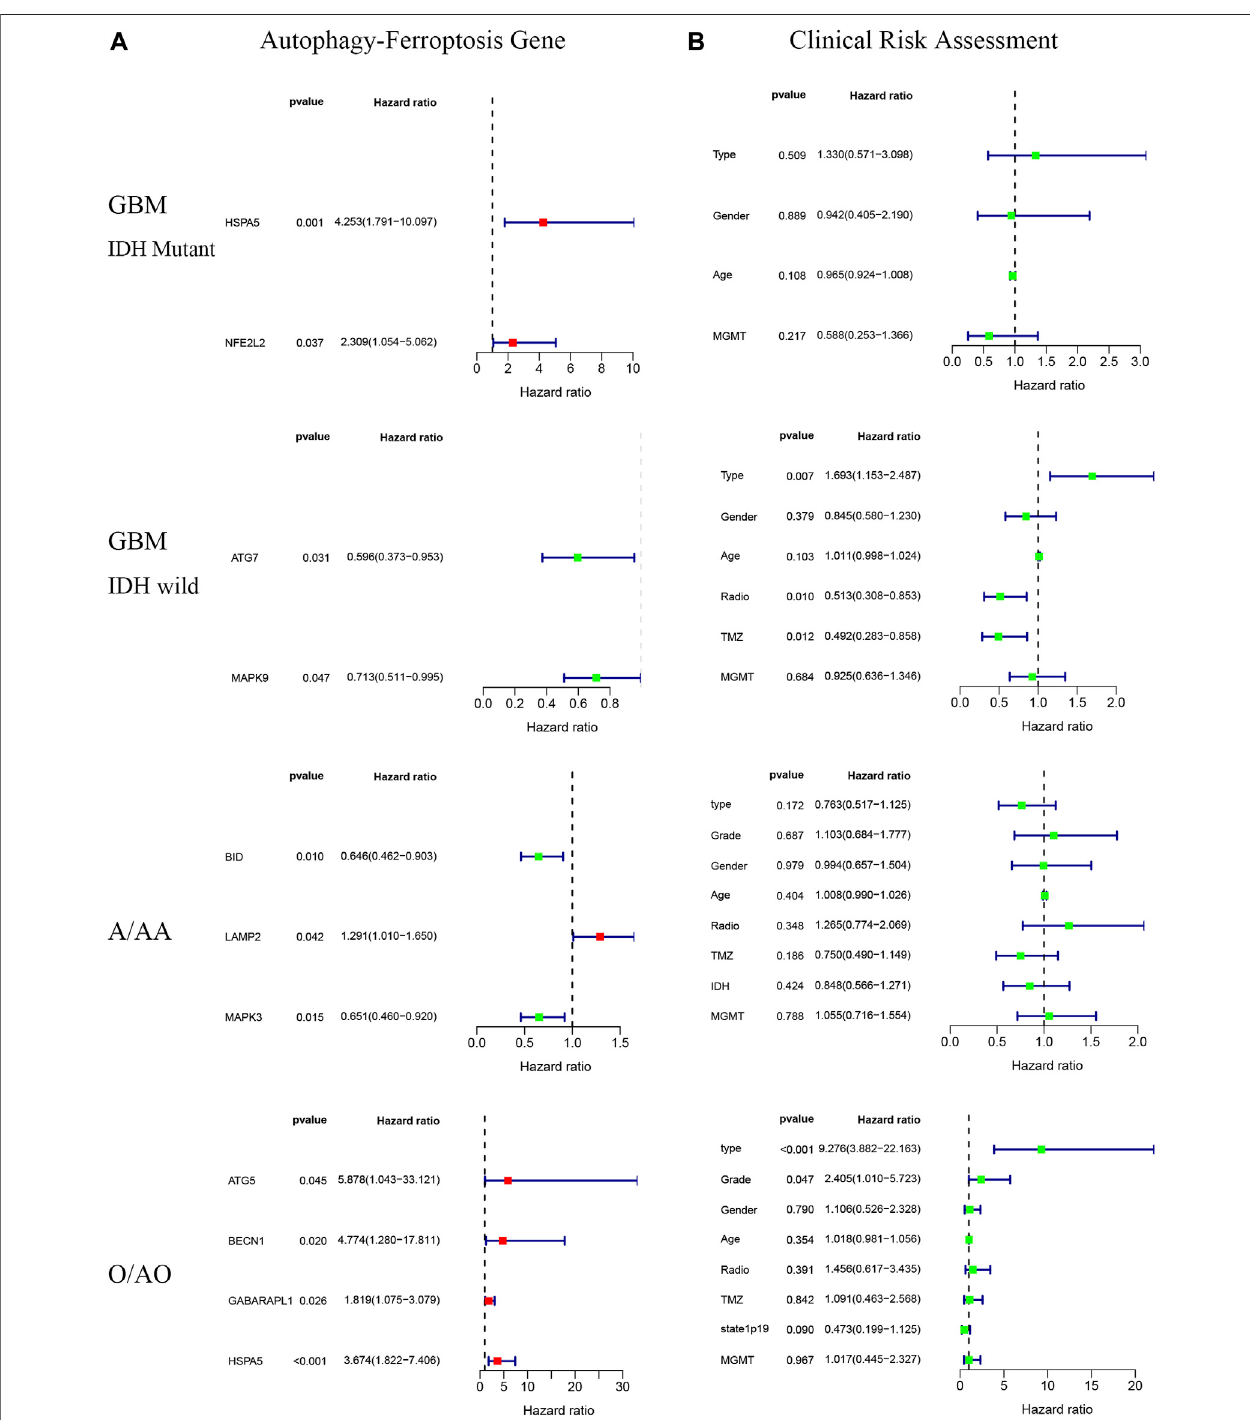
FIGURE 8 | Autophagy-ferroptosis prognostic gene (A) and clinical risk assessment (B) in different subgroups of glioma.